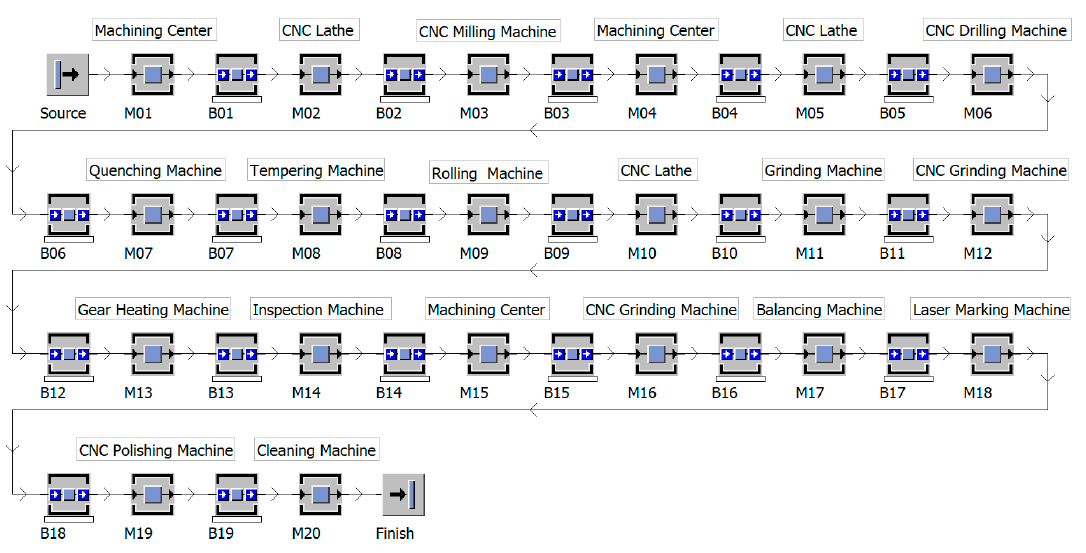
Figure 2. The machines and layout of an automotive part production line (CNC: Computer Numerical Control).